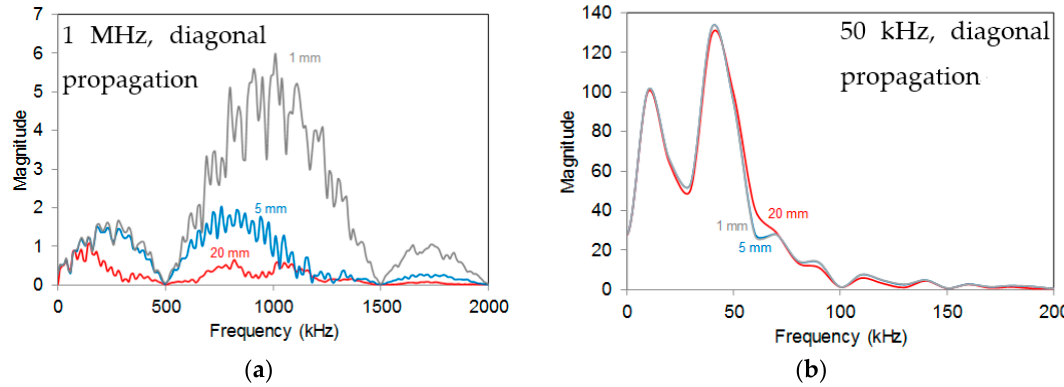
Figure 7. ( a ) FFT functions of waveforms received by different size sensors (exc. frequency at 1 MHz and diagonal source); ( b ) FFT functions of waveforms received by different size sensors (exc. frequency at 50 kHz and diagonal source).